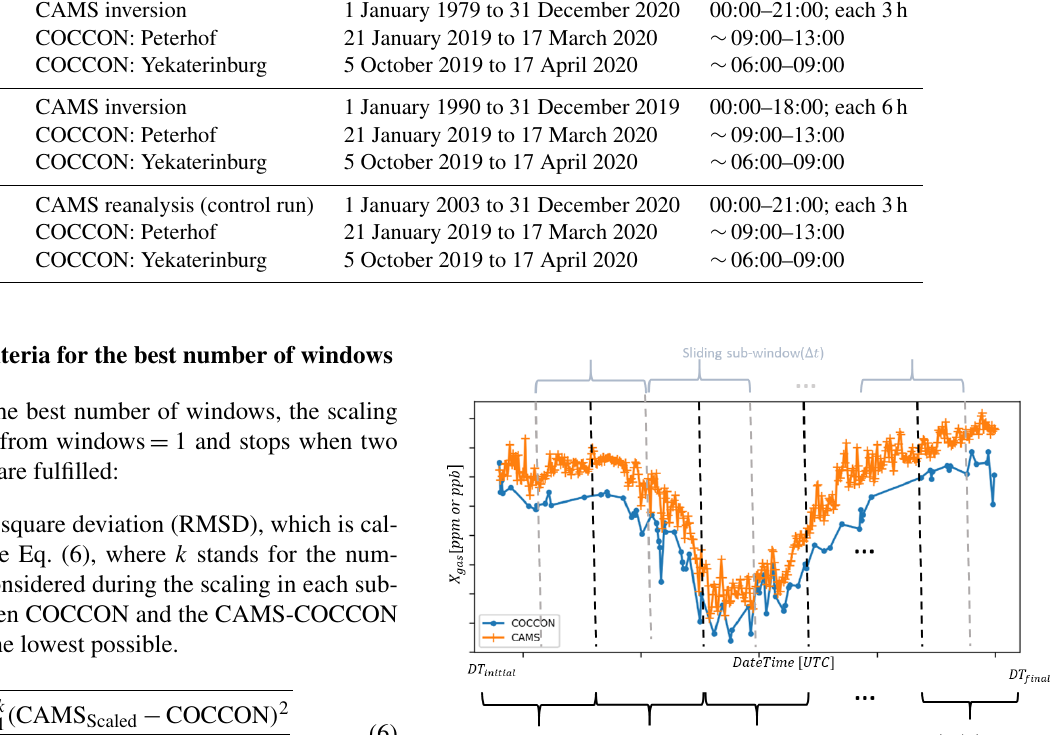
Table 3. Time range and usual daily time frame of the analysed results from CAMS and COCCON. Species